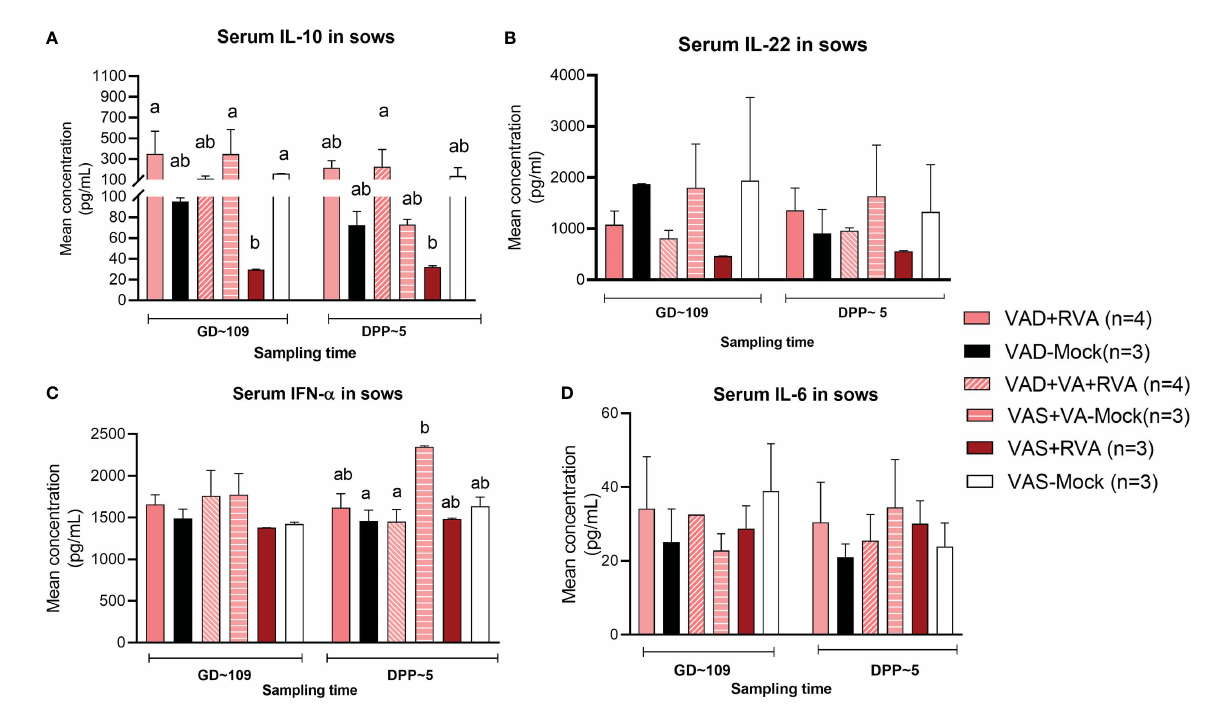
FIGURE 8 Pro-in fl ammatory and anti-in fl ammatory cytokine concentration in blood of sows. Blood was collected from sows at GD~109 (pre-partum) and DPP~5 (pre-partum) for cytokine analysis. (A) Mean concentration of serum IL-10. (B) Mean concentration of serum IL-22. (C) Mean concentration of serum INF- a . (D) Mean concentration of serum IL-6. Letters a and b indicate signi fi cant differences among treatment groups (mean ± SEM) at each time point determined using Kruskal-Wallis test and Dunn ’ s multiple comparison test, P ≤ 0.05. (GD, gestation day; DPP, day post-partum; VAD, vitamin A de fi ciency; VAS, Vitamin A suf fi cient; VA-vitamin